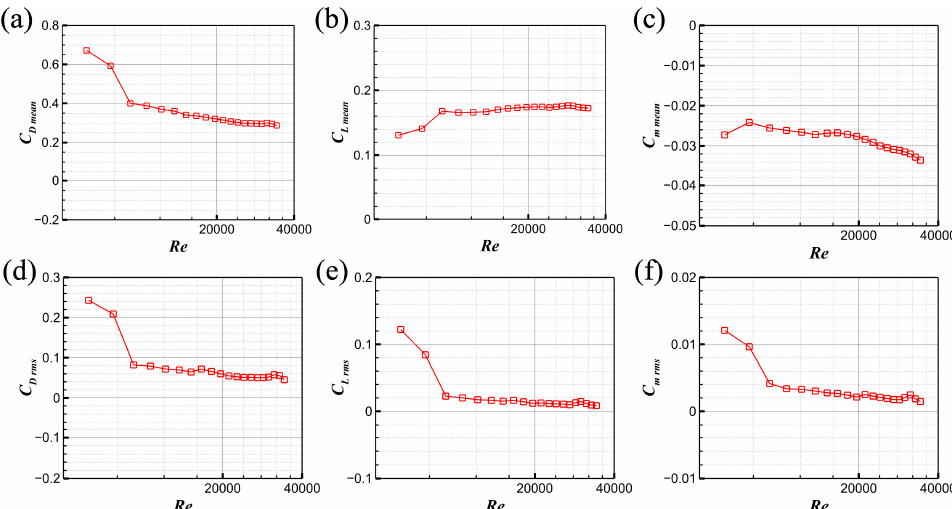
Figure 8. The mean surface pressure distribution of the twin-box girder at different Re: ( a ) the pressure surface distribution of the upper surface, and ( b ) the pressure surface distribution of the lower surface.